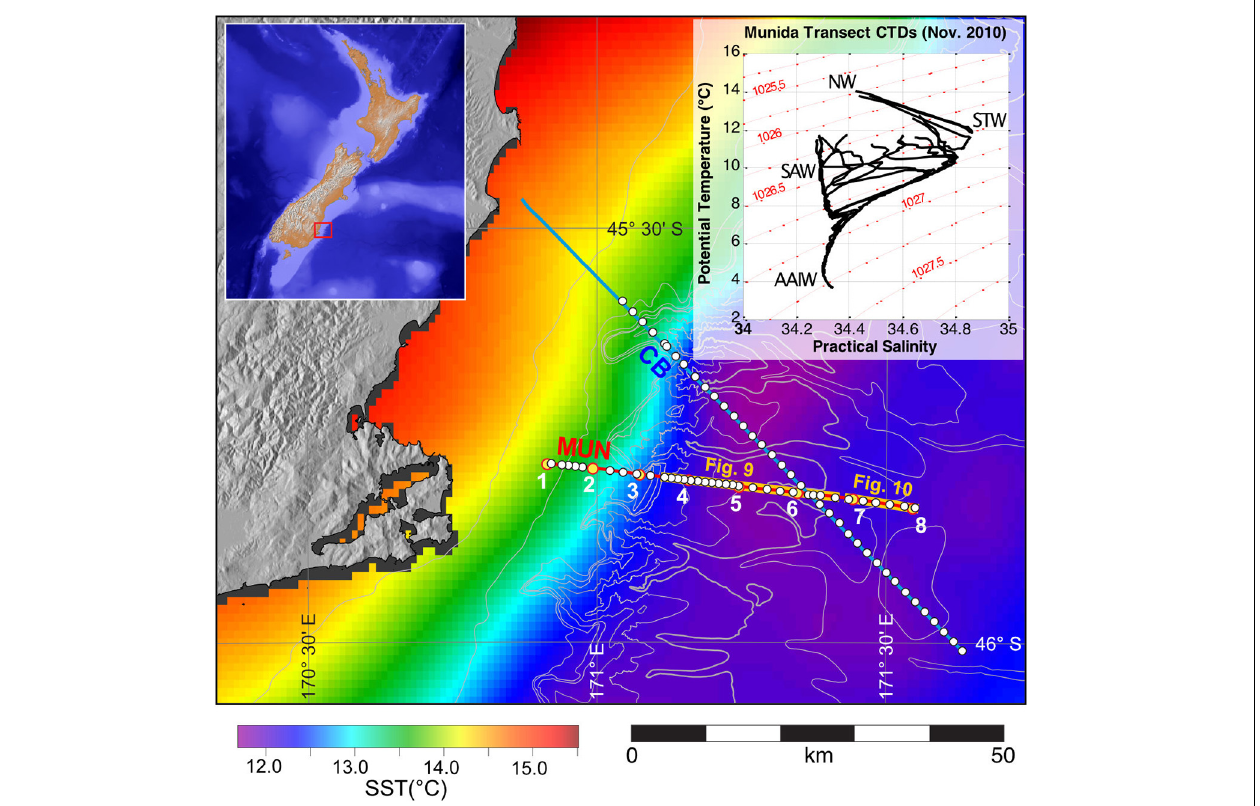
FIGURE 2 | Location of the Munida (MUN) and Canterbury Basin (CB) transects. Seismic lines KAH1201-1, -2, and -3 were acquired along transect MUN, and line KAH1201-5 was acquired along transect CB. SST dataset (same as in Figure 1 ) is enlarged to highlight focus area of this manuscript in the vicinity of the Subtropical Front. XBT positions are indicated by white dots. Subsets of transects shown in Figures 9 , 10 are highlighted. Inset in upper left shows a map including bathymetry in the region surrounding New Zealand. The area of the main figure is indicated by a red box. Land topography shading is derived from NASA’s SRTM data. Projection is UTM 59 South. Inset in upper right shows a temperature-salinity diagram based on eight conductivity-temperature-depth (CTD) profiles collected along the Munida transect in November 2010 (CTD cast locations are indicated by yellow dots in the main figure and are labeled 1–8). Red contours are potential density (in kg/m 3 ). Water mass interpretations are labeled: NW, Neritic Water; STW, Subtropical Water; SAW, Subantarctic Water; AAIW, Antarctic Intermediate